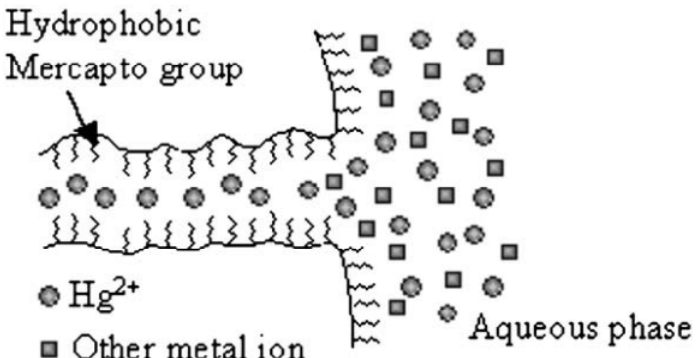
Figure 12. Difference between adsorption mechanism of Hg 2+ and other metallic